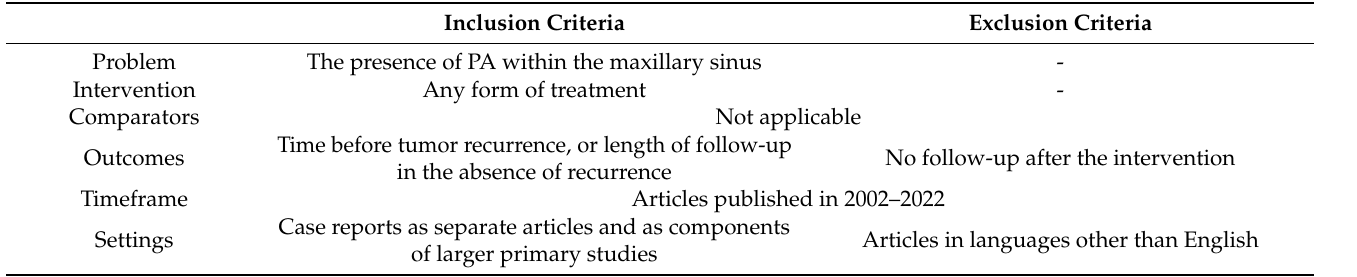
Table 1. Criteria for inclusion and exclusion of